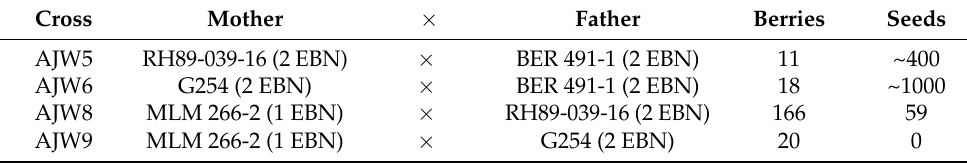
Table 2. Resistant wild Solanum genotypes can be crossed to susceptible S. tuberosum . Selected re-